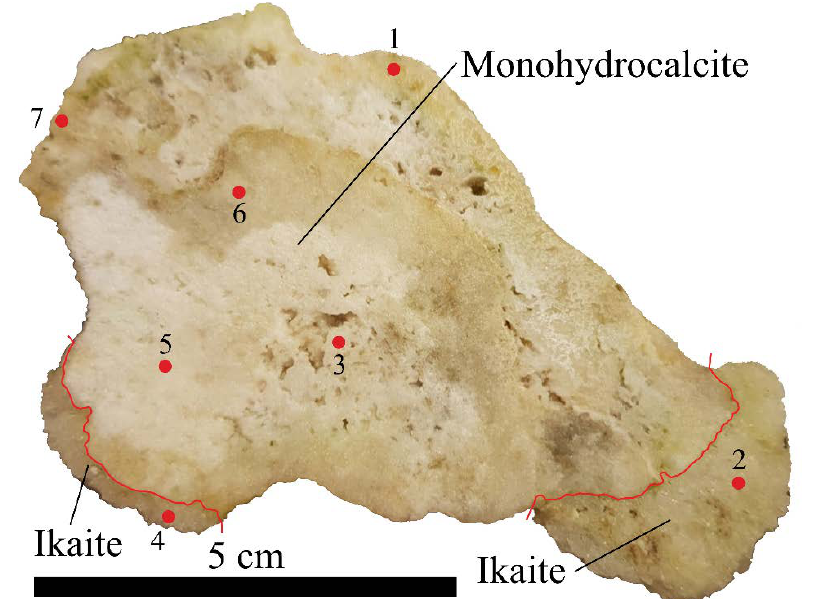
Figure 7. Photograph of the columnar slice of Column 1-2021 investigated with Raman at seven spots (red circles). Ikaite growth were found in the grey areas marked with red lines. The remaining spots were identified as monohydrocalcite.